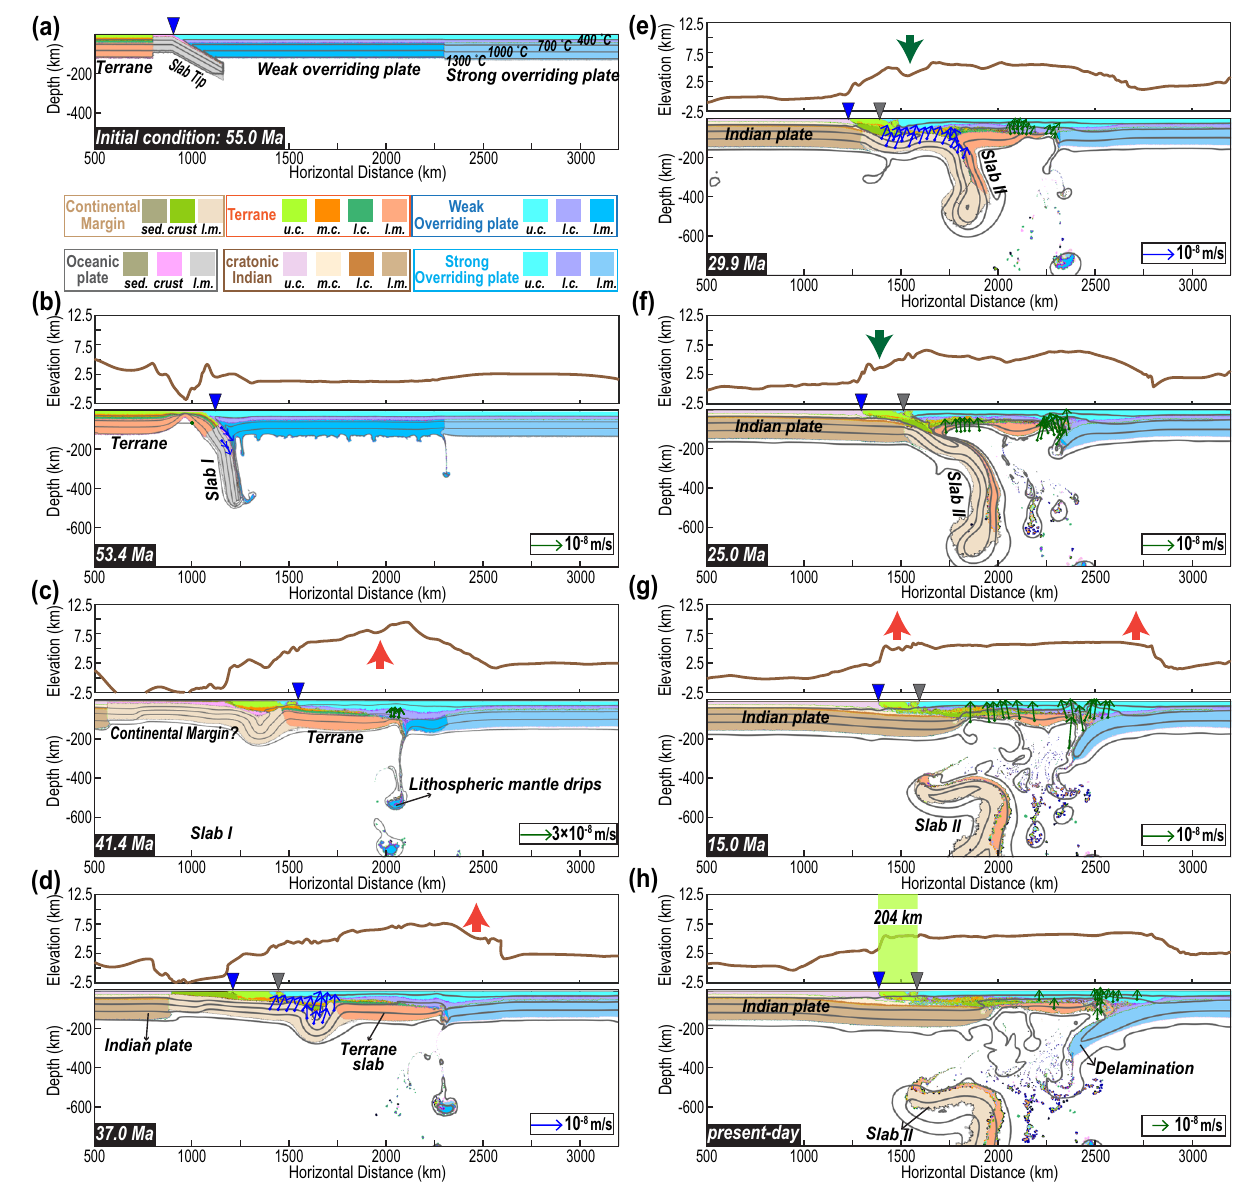
Fig. 5 | Cenozoic subduction and Tibetan evolution. a – h Snapshots of the modeledmaterial fi eldandsurfacetopography.Thematerial fi gures:bluetriangles marktheactivetrench,andgreytrianglesmarktheabandonedones;Greenarrows demonstrate the melting locations, while the blue ones present the locations for oceanicslabdehydration.Theredandgreenboldarrowsinthetopography fi gures demonstrate the locations where uplift and subsidence happen, respectively. The lightgreenboxin h markstherangeofaccretedcrustbeforetheindentationofthe